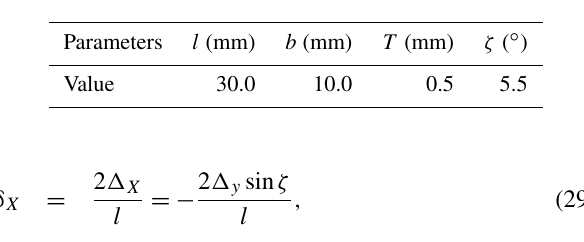
Table 3. Key geometric parameters of the bistable compliant mech-